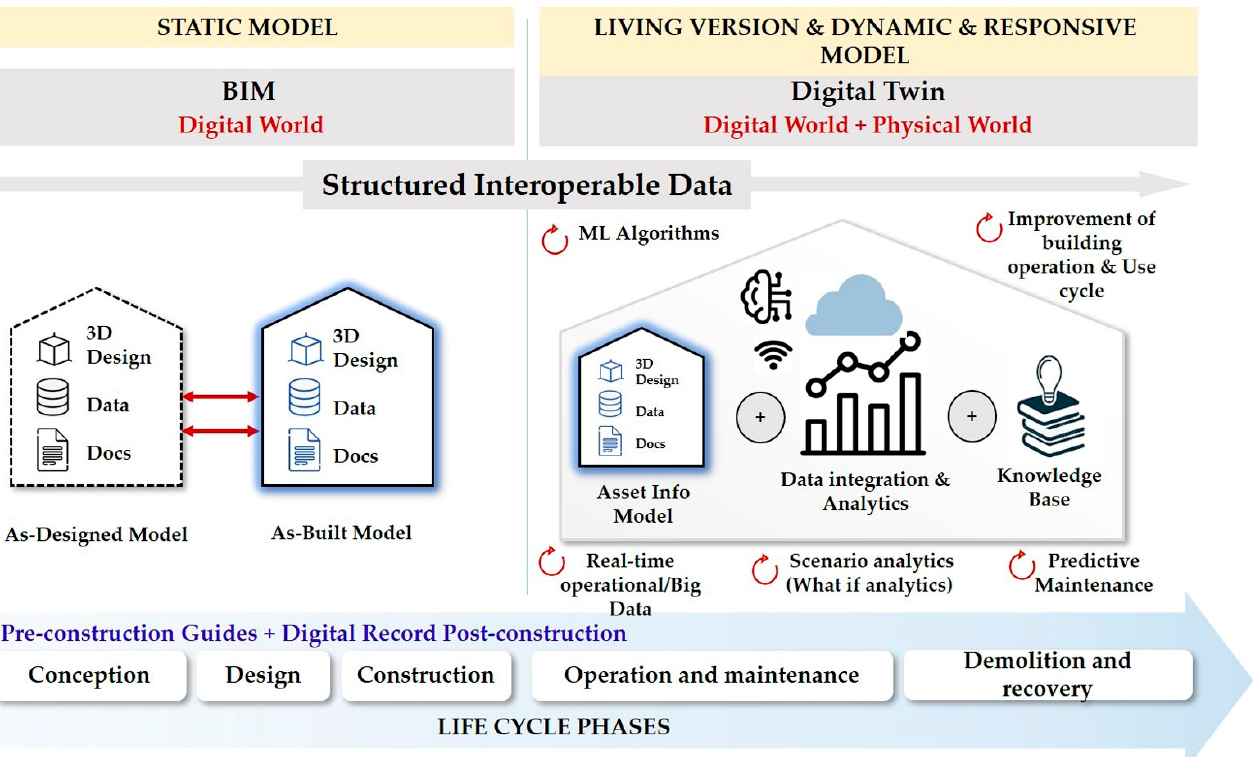
Figure 5. Five-level ladder taxonomy from BIM to DTs. Adapted from [6,60,64] .